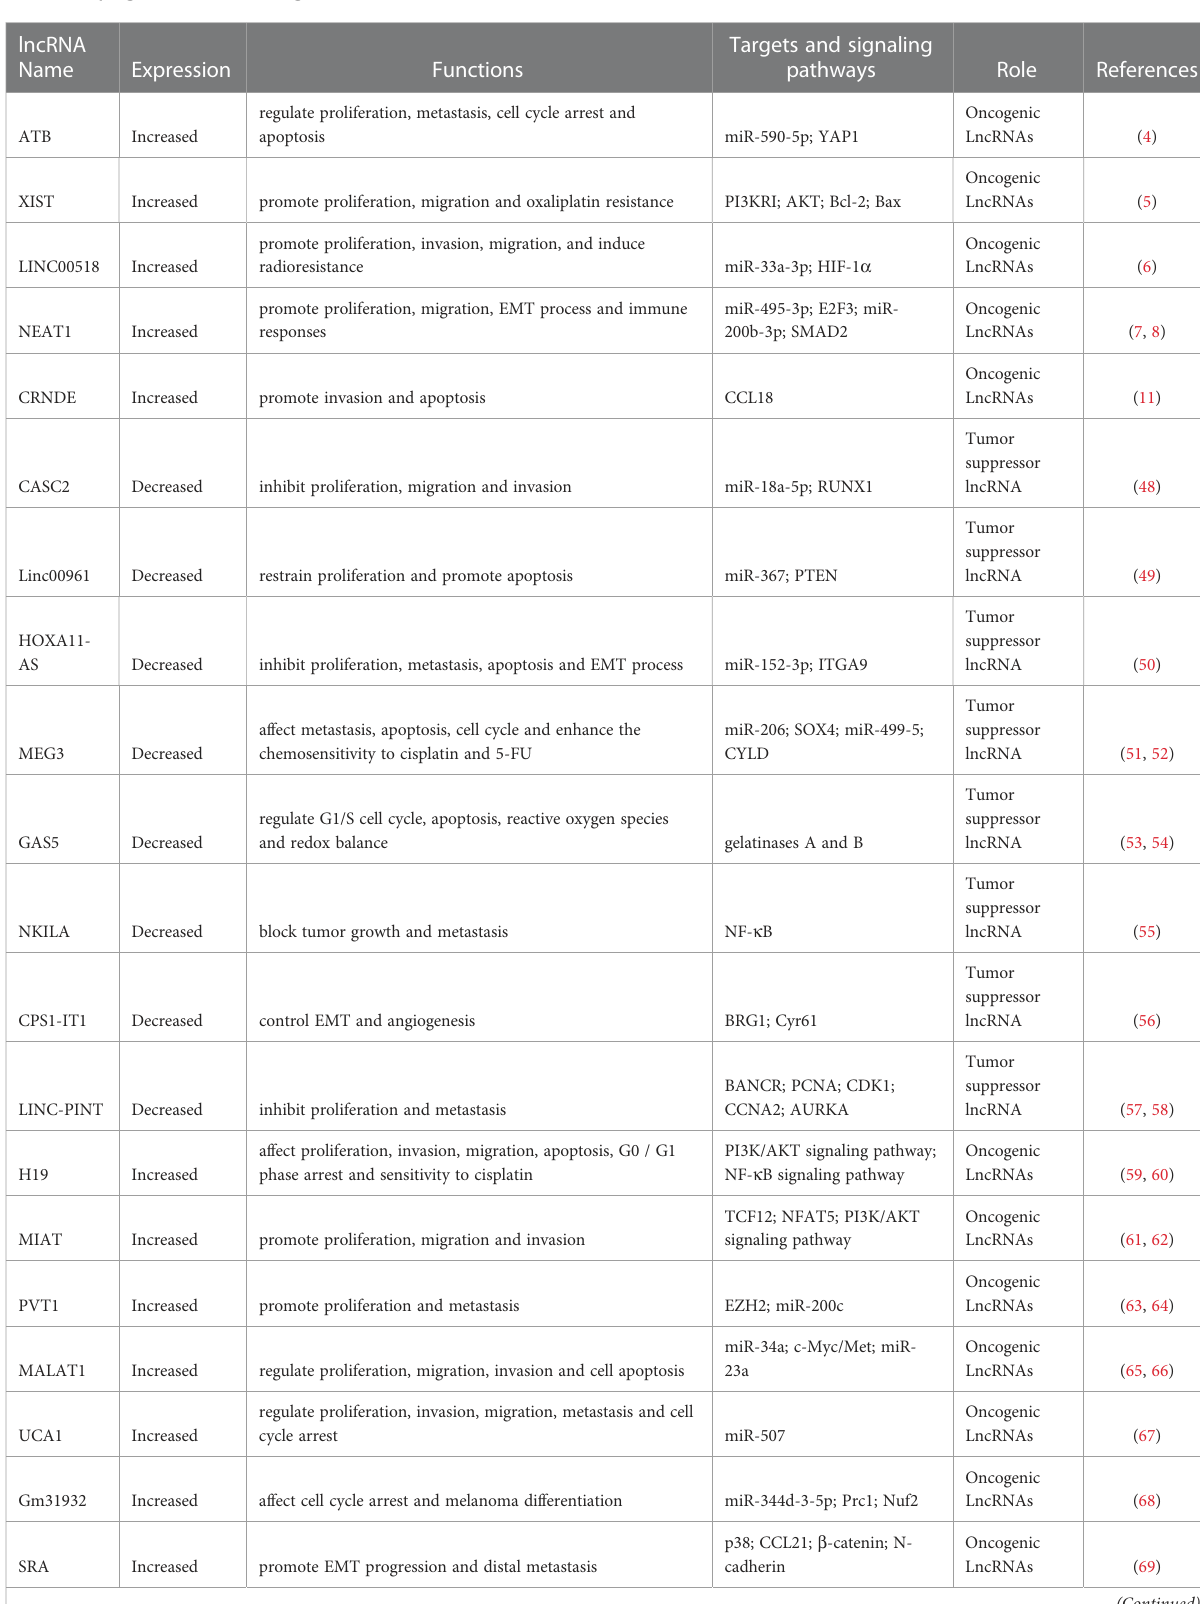
TABLE 1 Upregulated and Downregulated LncRNAs in Melanoma.